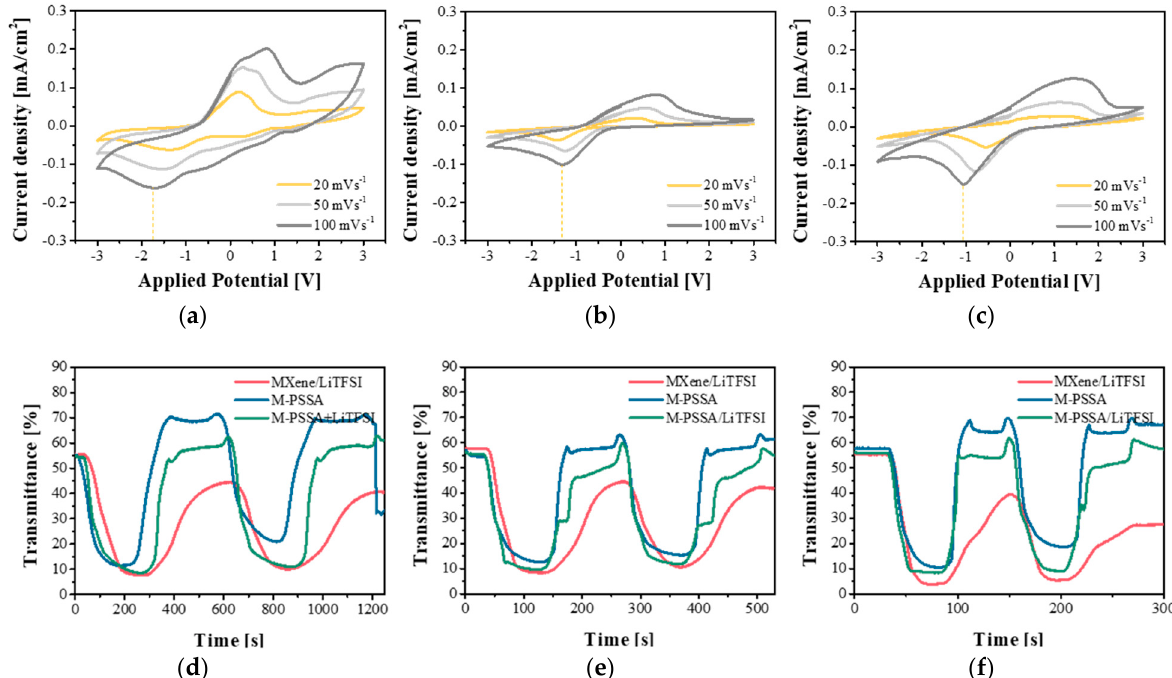
Figure 4. Cyclic voltammetry of ( a ) MXene/Bis(trifluoromethylsulfonyl)amine lithium salt (MXene/LiTFSI), ( b ) poly(4- styrenesulfonic acid) crosslinked with MXene (M-PSSA) and ( c ) 1:20 LiTFSI in MXene-PSSA(M-PSSA/LiTFSI) at different scan rates, and the corresponding transmittance vs time at the wavelengths of 600 nm for ( d ) 20 mV s − 1 , ( e ) 50 mV s − 1 , and ( f ) 100 mV s − 1 .